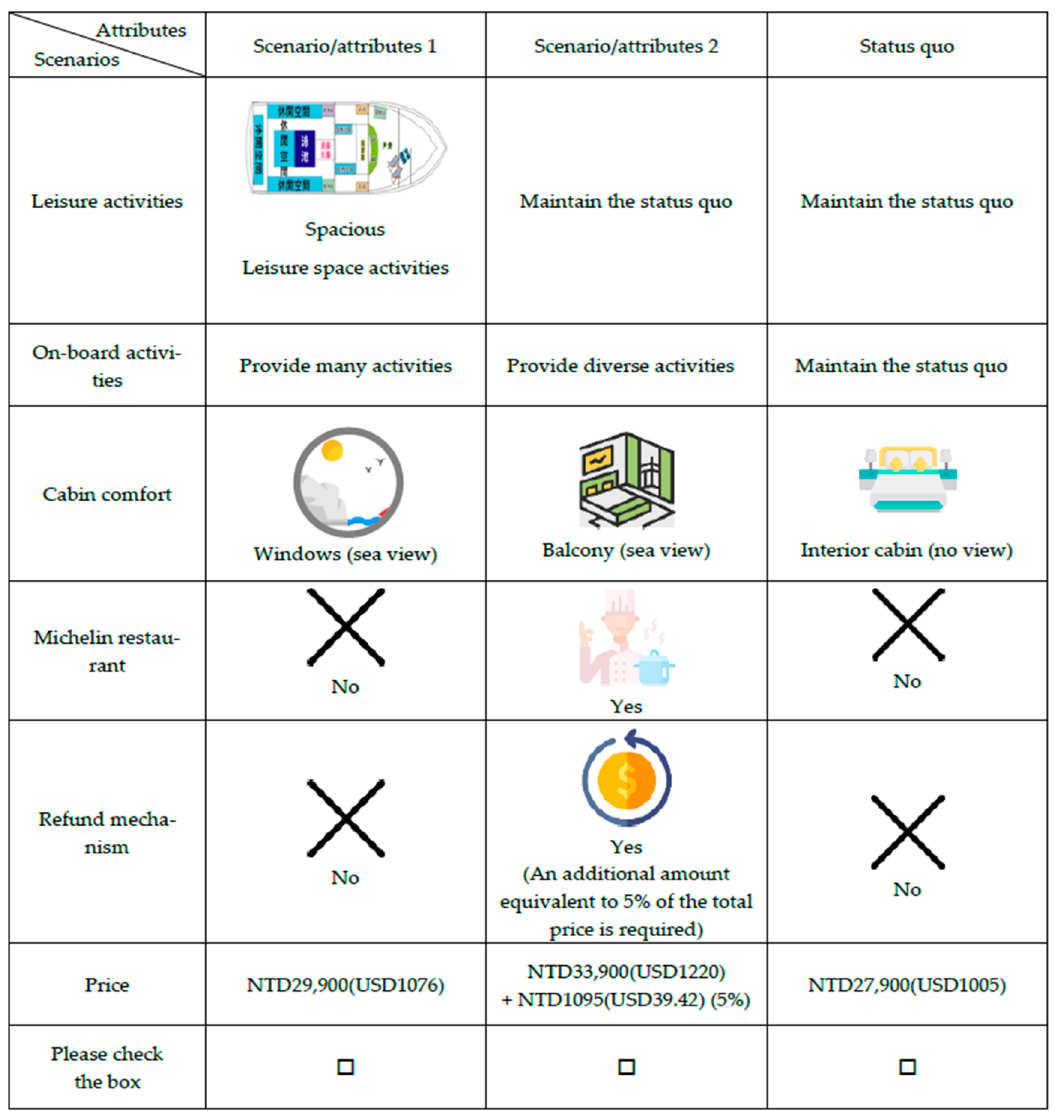
Figure 1. Example questionnaire choice Figure 1. example questionnaire choice set.